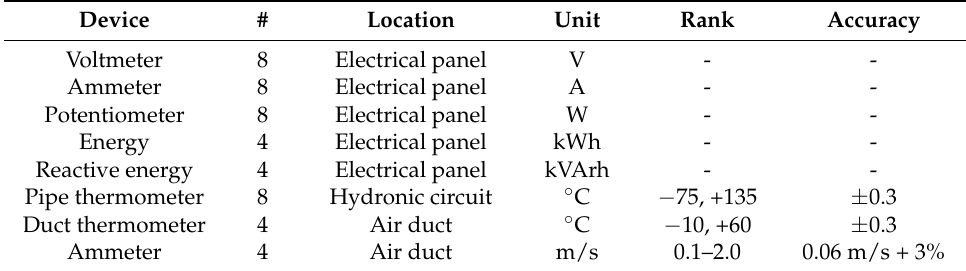
Table 3. Probes in the air-conditioning system.